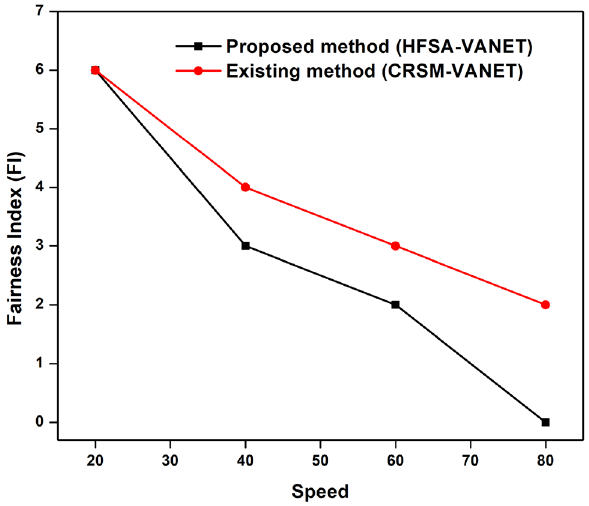
Figure 12. Speed vs fairness index plot for a proposed and existing